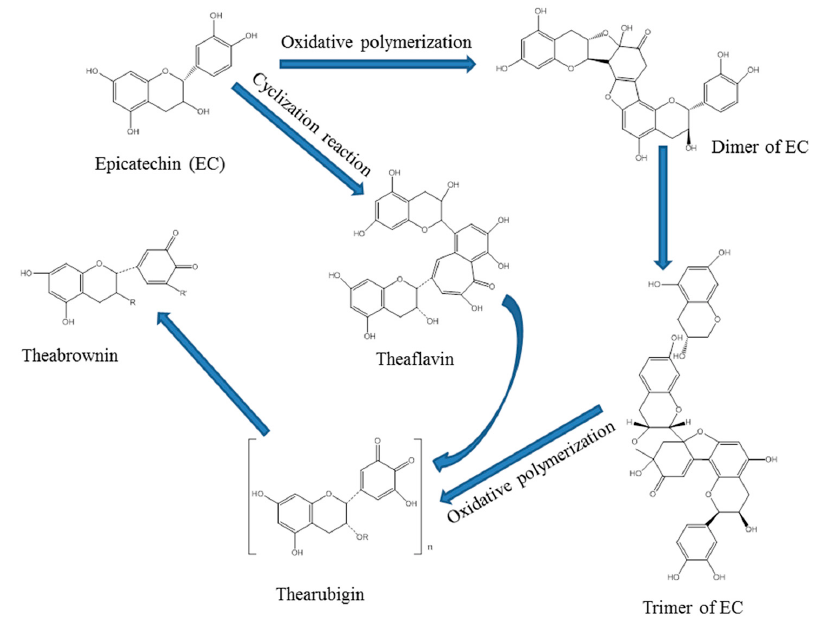
Figure 8. Major conversion pathways concerning non-enzymatic oxidation between catechin and tea pigments.